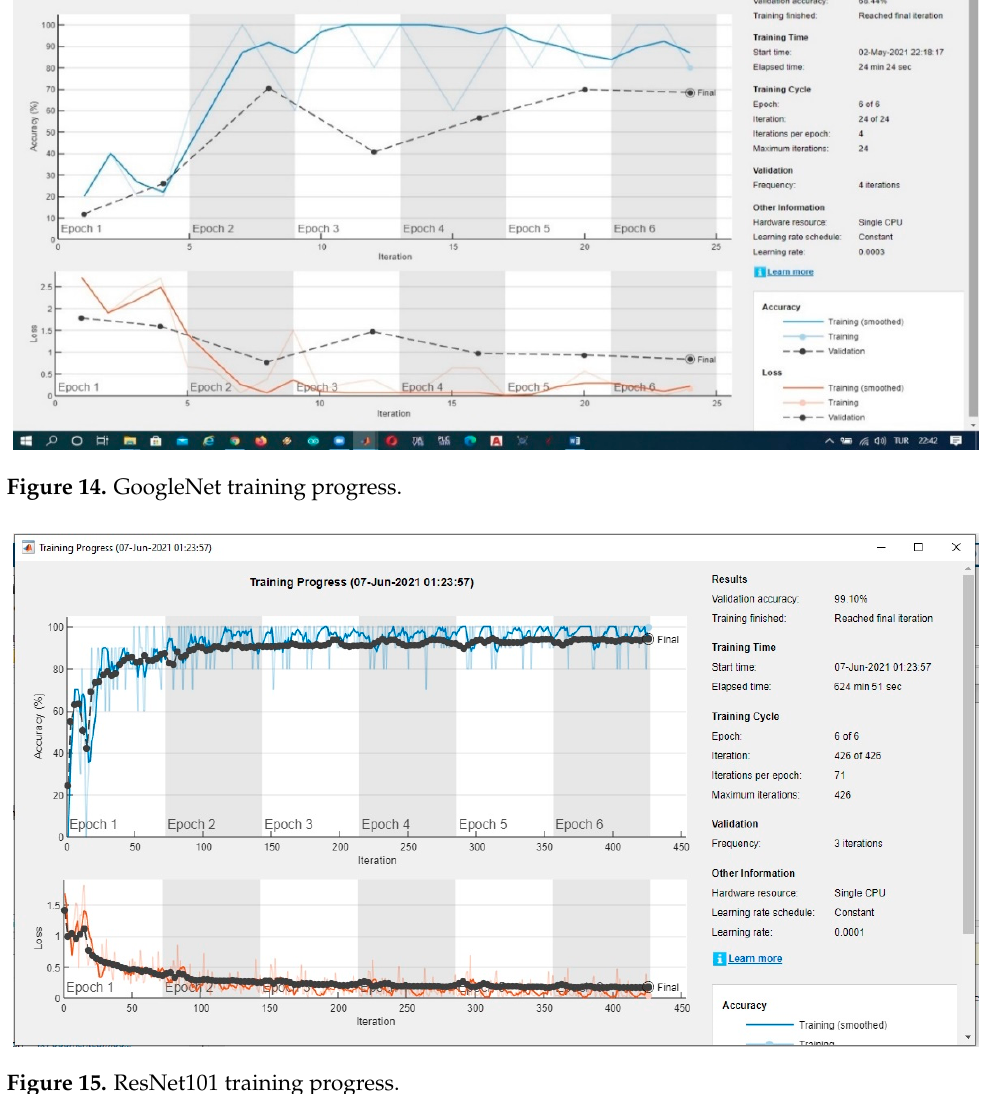
Figure 15. ResNet101 training progress.